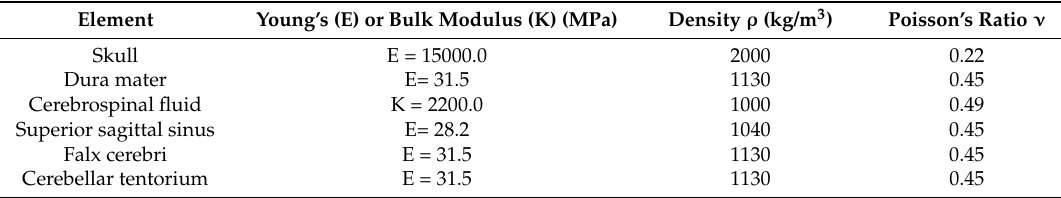
Table 1. Mechanical properties for each component of the head [21,40].